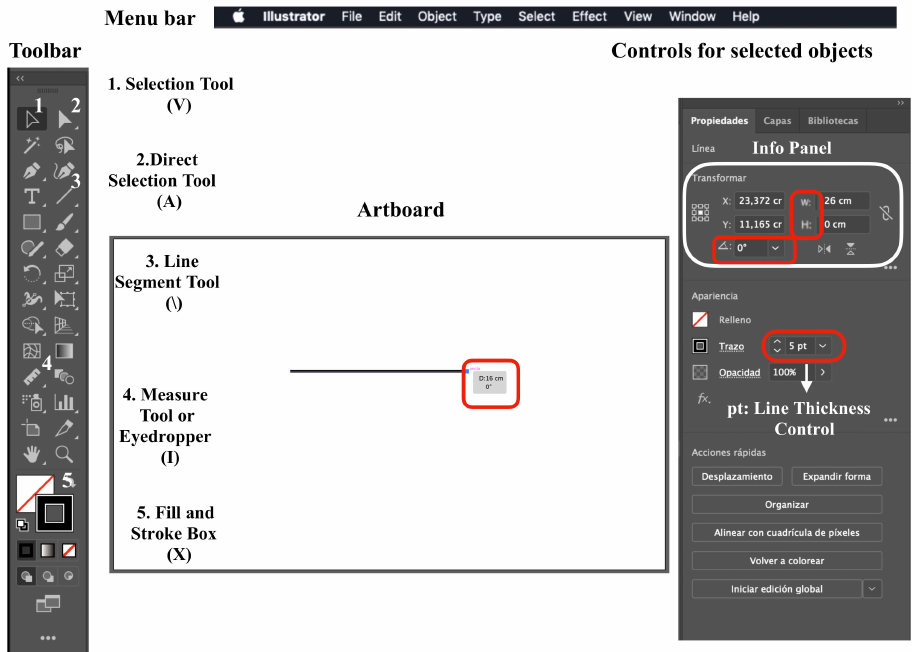
Figure 2. Adobe Illustrator workspace. (V): selection tool command, (A): direct selection tool command, ( \ ) line segment tool command, (I): measure tool or eyedropper command, (X): fill and stroke box command to change color, (W): linear segmentlLength, pt: points that compose the linear segment thickness.